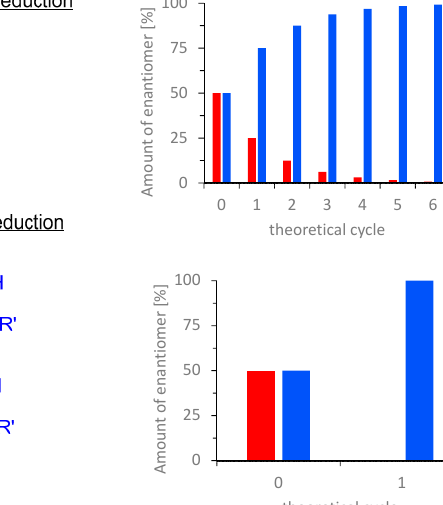
theoretical cycle